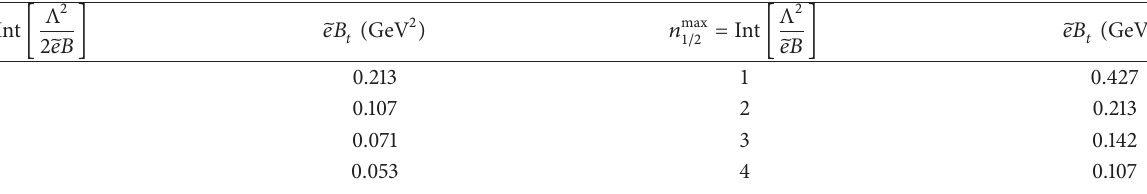
Table 1: The value of transition magnetic field ̃𝑒𝐵 𝑡 at successive numbers of fully occupied lowest Landau levels 𝑛 max 𝑎 where 𝑎 = 1,1/2 are the ̃𝑄 two possible values of the rotated charge .